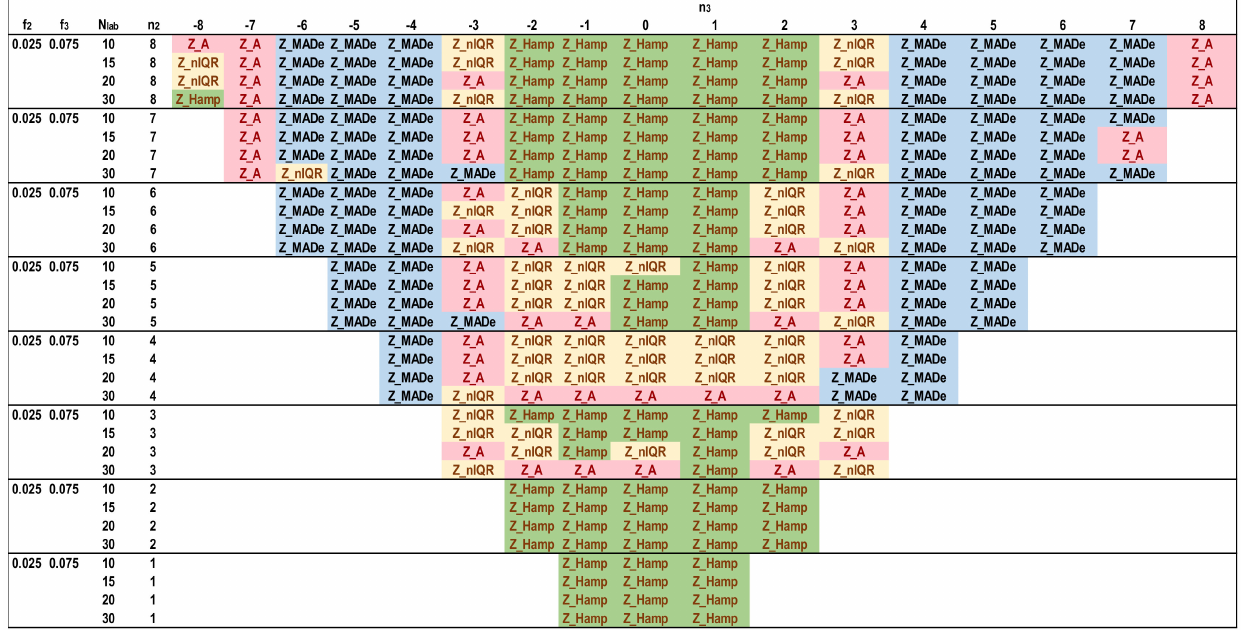
Figure 14. Optimal robust estimators of Zu% for trimodal distributions, f 2 = 0.025 and f 3 = 0.075.